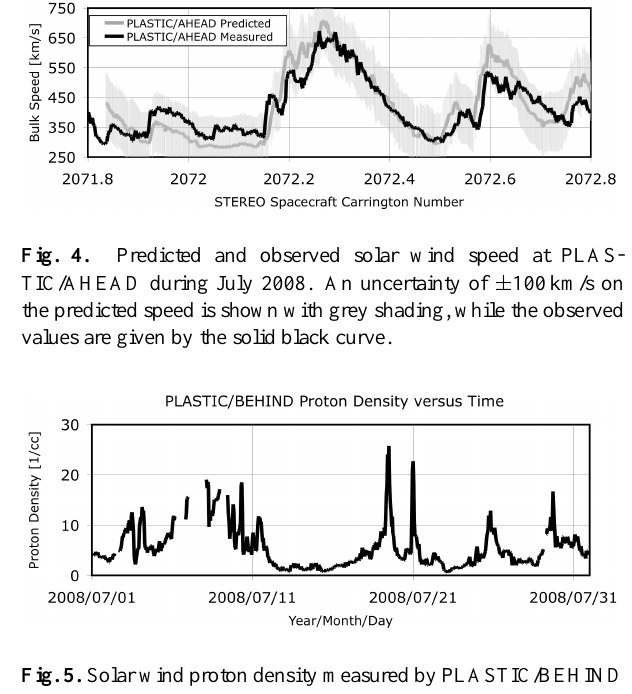
Fig. 5. Solar wind proton density measured by PLASTIC/BEHIND in July 2008.